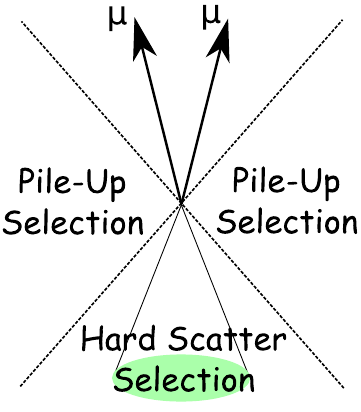
Fig. 30 A diagram displaying the regions of r – φ phase space which are expected to be dominated by hard-scatter jets (opposite in the r – φ plane to the Z → μμ decay) and where there is greater sensitivity to pile-up jet activity (perpendicular to the Z → μμ decay)